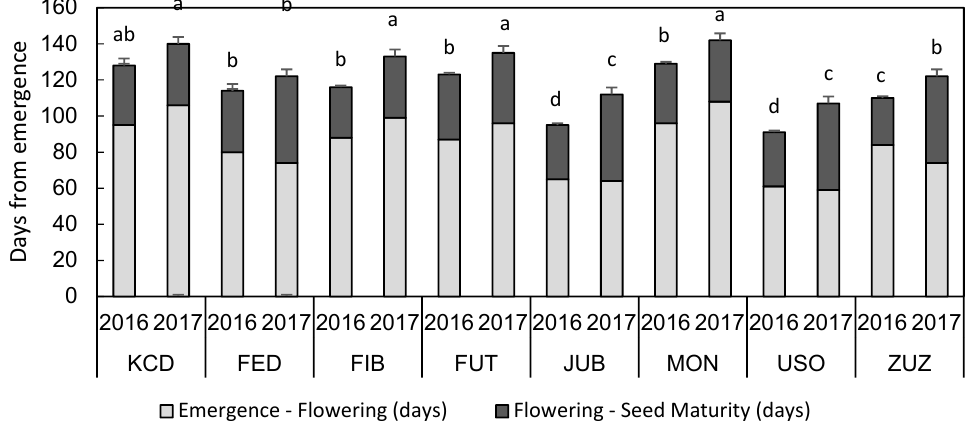
Figure 1. Main growth stages duration of hemp cultivars studied (KCD = KC Dora; FED = Fedora 17; FIB = Fibrol; FUT = Futura 75; JUB = Jubileu; MON = Monoica; USO = Uso-31; ZUZ = Zuzana). Means followed by the same letter are not significantly different (SNK at the 5% level). Error bars, as standard deviations, referred to the emergence-seed maturity period.